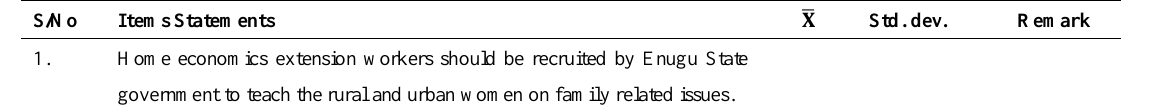
Table 5: Mean and Standard deviation of responses of respondents on how Home Economic Education will help to curb the insecurity and inflation challenges in Enugu